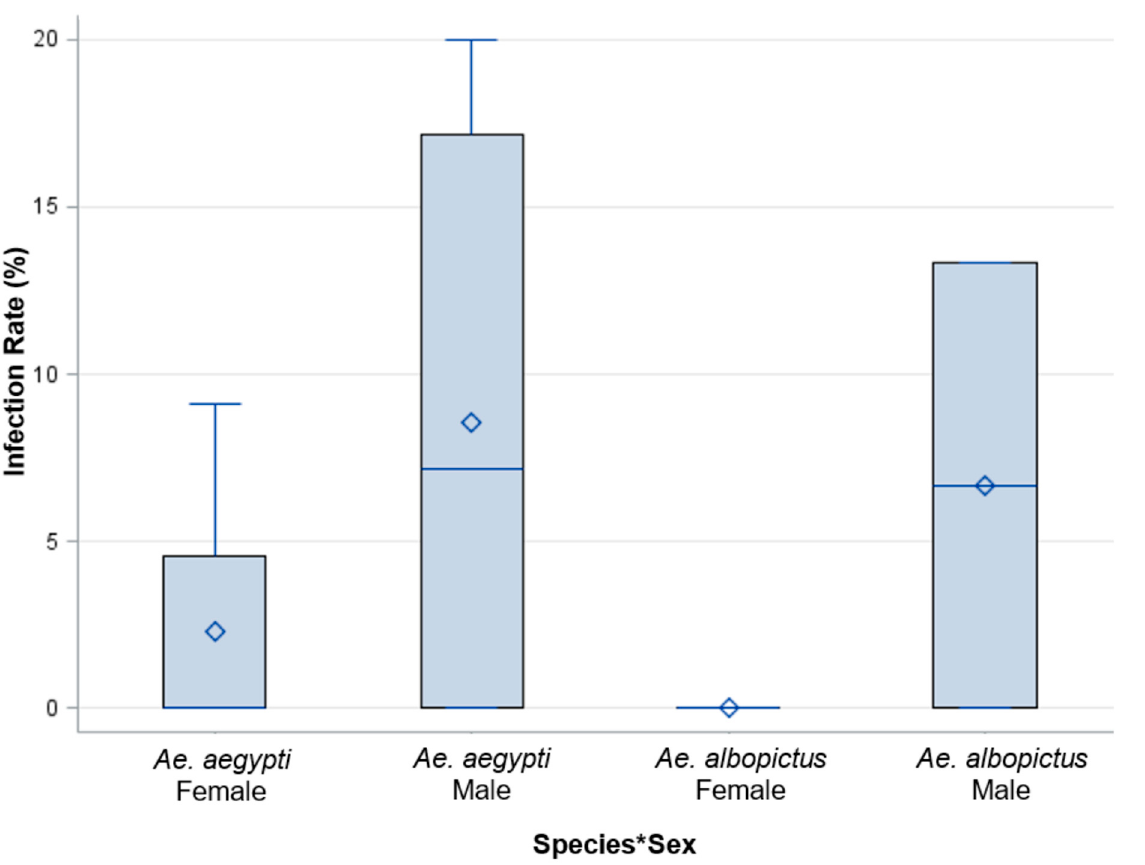
Figure 8. Saliva expectorates were examined for ZIKV from adult female progeny, and whole bodies of adult male progeny were examined for the presence of ZIKV from parents fed 6 log 10 PFU/mL ZIKV infected blood. The analysis of variance did not show a significant difference between species, sex, or their interaction. The species by sex interaction is represented by